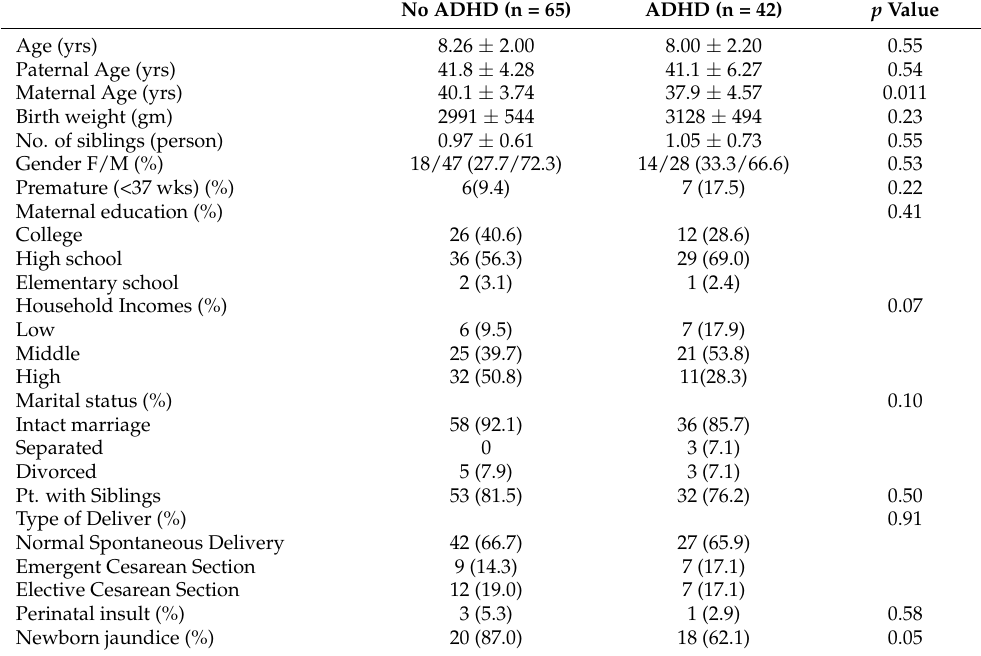
The comparison of baseline characteristics of school-age children with Attention- Deficit/Hyperactivity Disorder (ADHD) versus no ADHD in the hospital-based